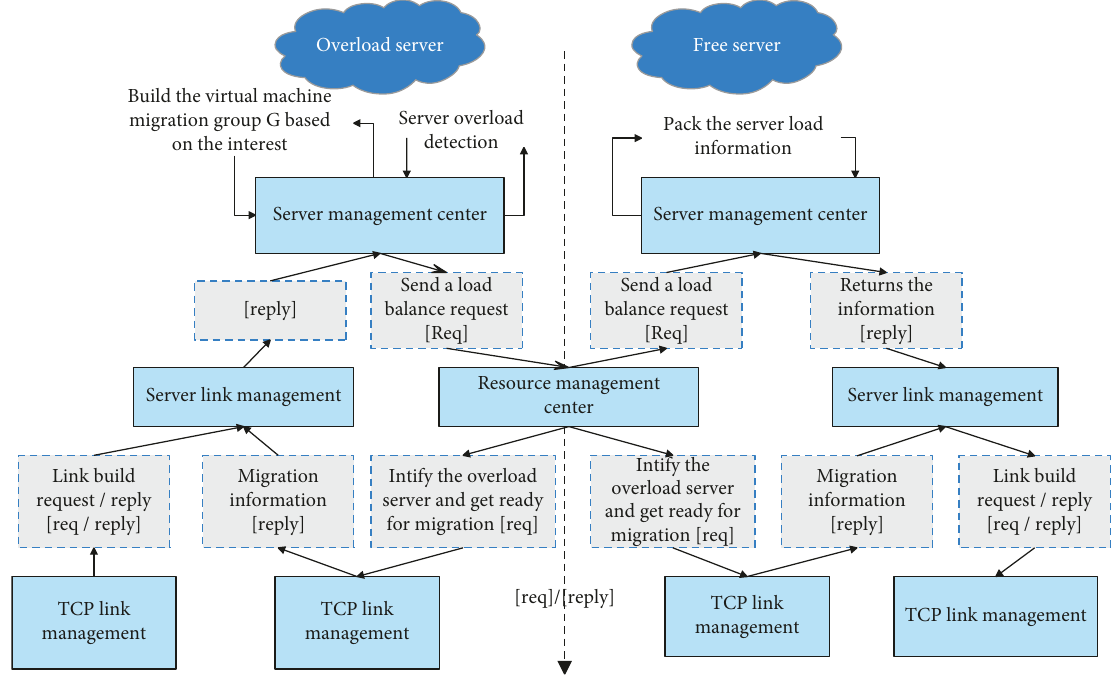
Figure 7: The selection process of the target server.